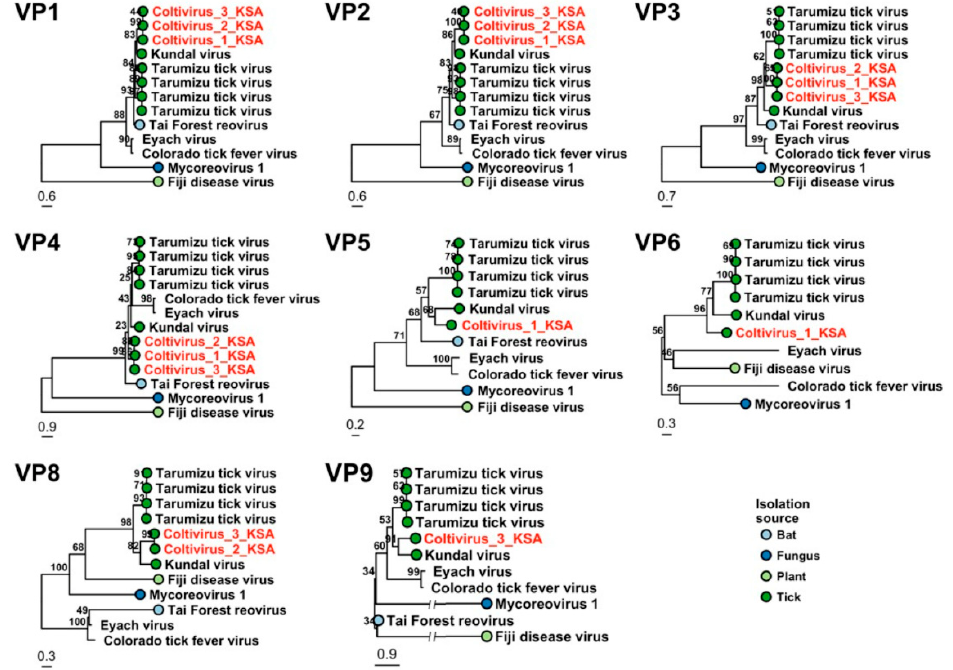
Figure 6. Phylogenetic trees based on VP1 to VP6, VP8 and VP9 genes of genus Coltivirus The viruses detected in Saudi Arabia are marked with red color.